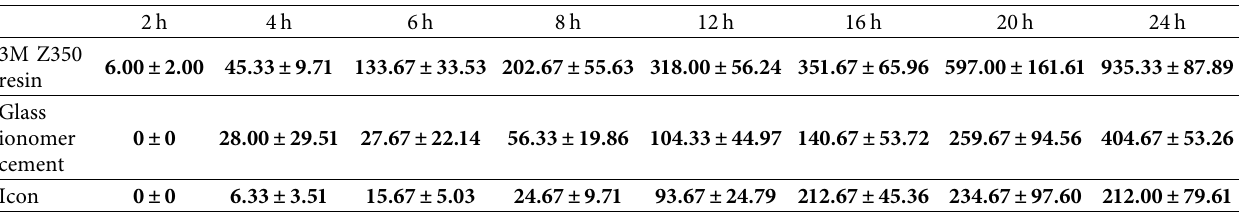
Table 4: Streptococcus mutans group (electron microscopy